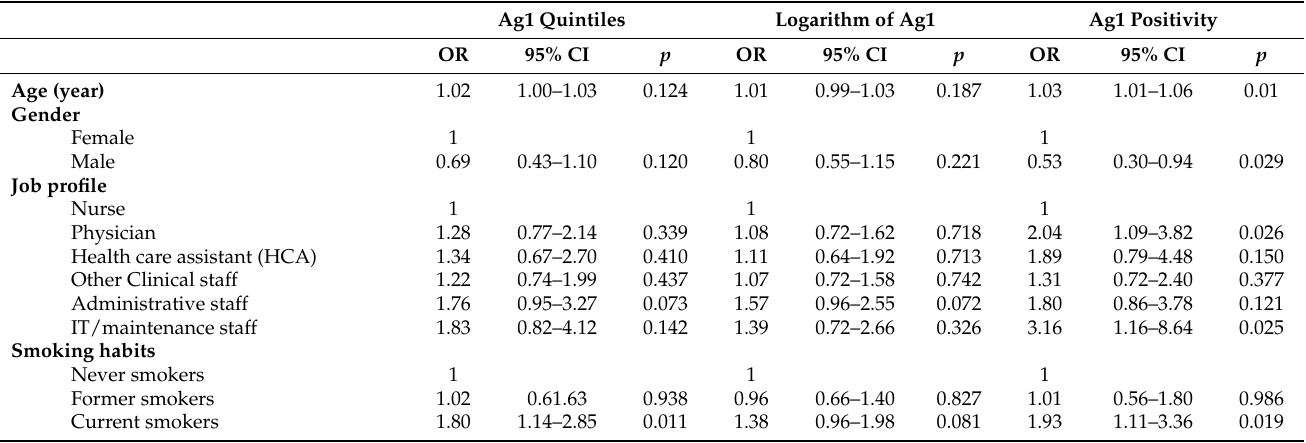
Table 3. Multivariable analyses (ORs and 95% CI) for the predictors of Ag1 cellular response among 419 vaccinated HCW of CSS, using different outcomes: quintiles of Ag1 (low vs. high, ordinal logistic regression, first column); logarithm of Ag1 (second column); positivity of Ag1 (third column). Ag1